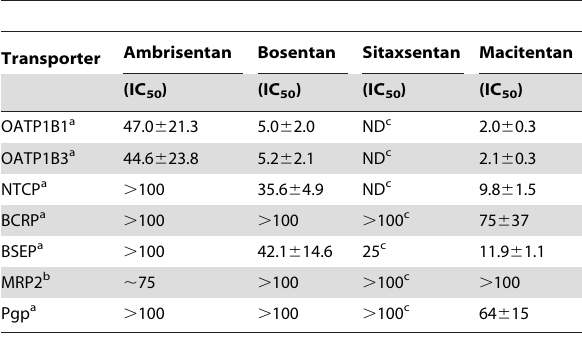
Table 1. Effect of Ambrisentan, Bosentan, Sitaxsentan, and Macitentan on Hepatic Uptake and Efflux Transporters.